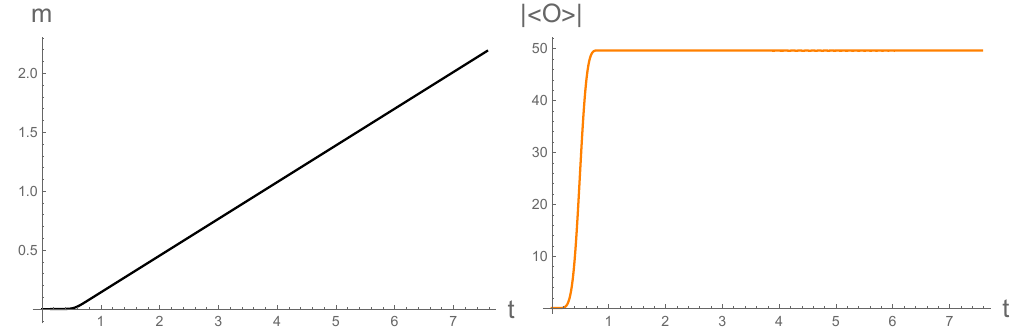
Figure 28 . Left: phase portrait of the late-time dynamics of a quench process of the form (3.1) with (cid:15) = 0 : 09 ; ! b = 2 and (cid:12) = 20. We start at t = (cid:12) . Each period of the source has a di(cid:11)erent color, whose wavelength increases the later it starts. Right: relative value of the imaginary part of the nonlinear conductivity (cid:27) . A nonzero value indicates that the system response is partially in-phase with the driving.